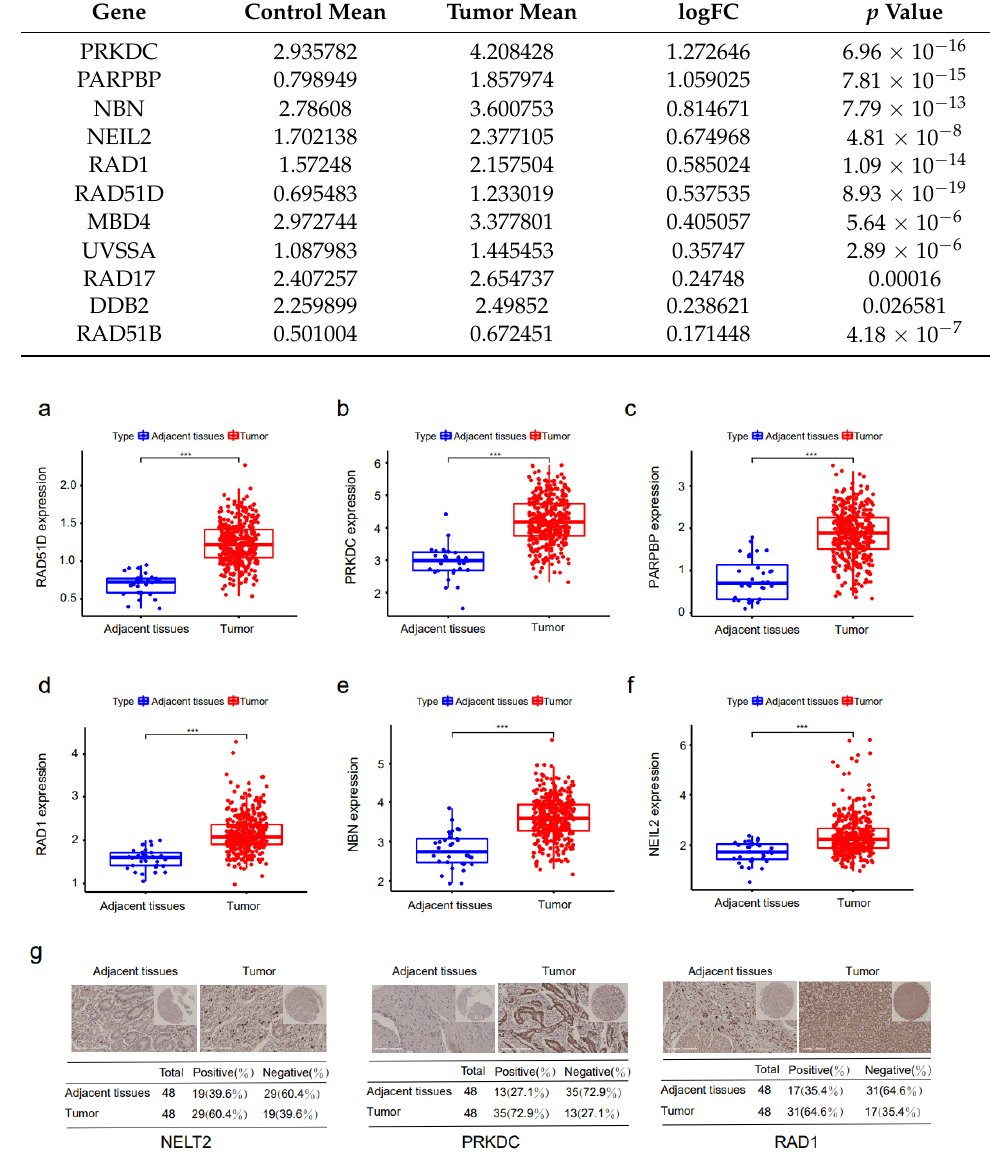
Figure 6. The expressing levels of DNA repair genes between STAD tumor tissues and neighboring ordinary tissues. ( a – f ) The mRNA expression level of host genes whose alternative splicing is obviously related to the prognosis of STAD patients’ overall survival between STAD tumor